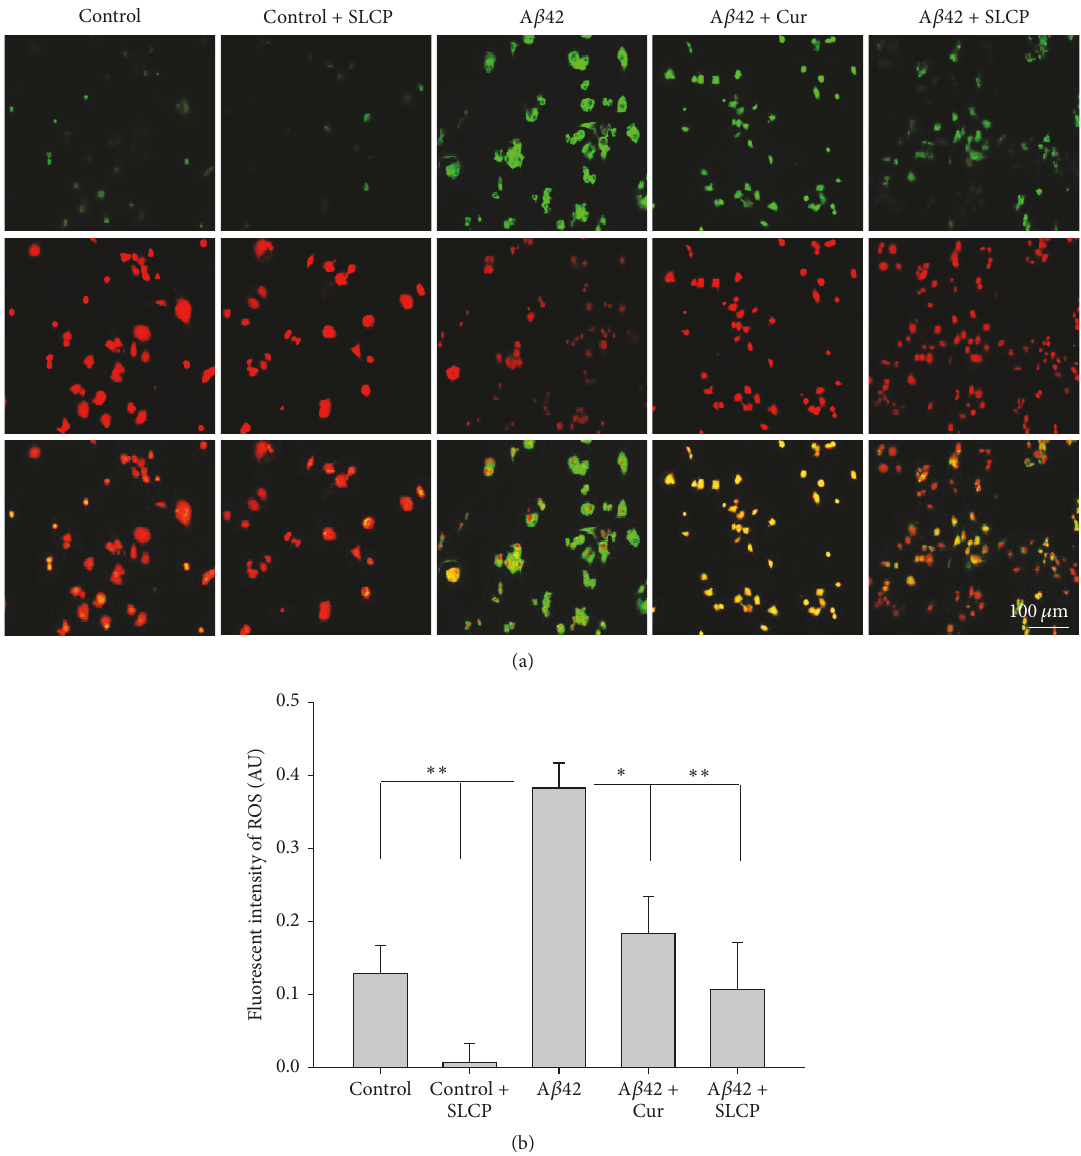
Figure 3: SLCP decreases A 𝛽 42-induced ROS formation. N2a cells were treated with A 𝛽 42 (10 𝜇 M) for 24 h in presence or absence of SLCP (1 𝜇 M) before being stained with CellROX oxidative stress reagents for detection of ROS levels. (a) ROS immunofluorescent (green) was increased by A 𝛽 42, while Cur- and SLCP-treated cells decreased the green fluorescent signal. (b) Quantification of the fluorescent signals showed that A 𝛽 42-treated cells had significantly increased ( ∗ 𝑝 < 0.05 ; ∗∗ 𝑝 < 0.01 ) ROS production, while SLCP prevented the A 𝛽 42-induced increase in ROS more effectively than did dietary Cur. Scale bar indicates 100 𝜇 m and is applicable to all other